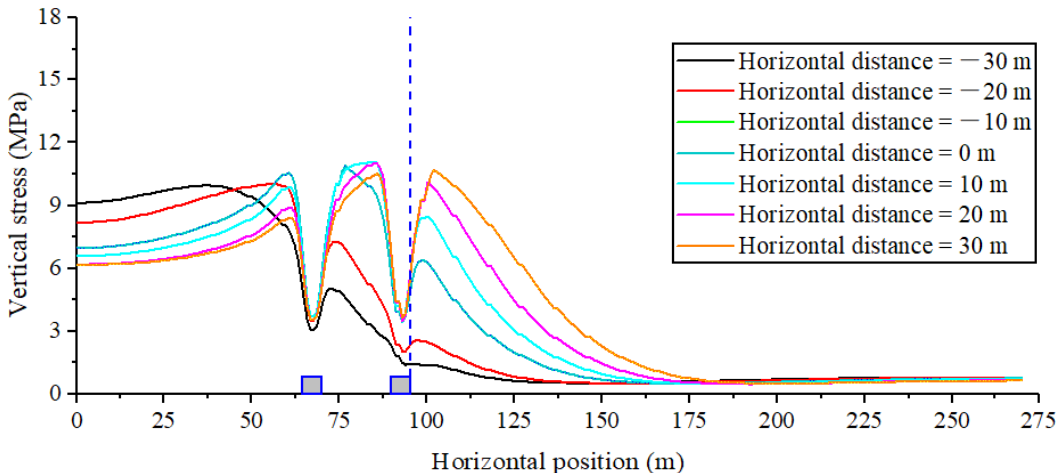
Figure 6. Distribution of immediate roof stress at different horizontal distances.